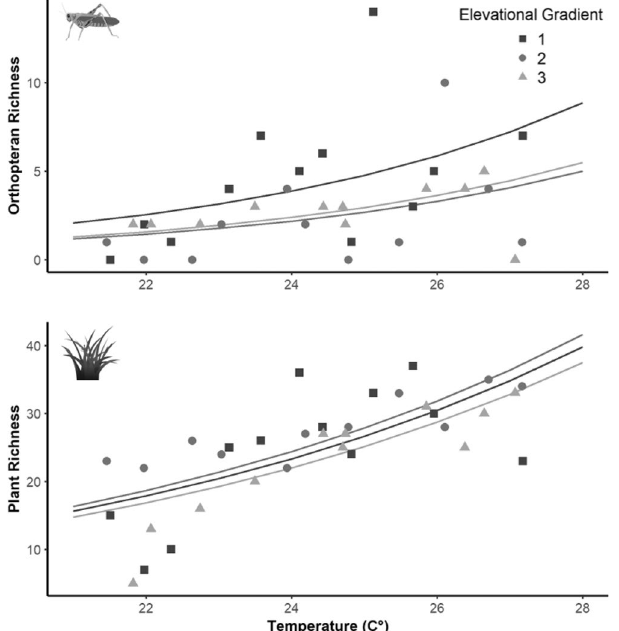
Figure 3. Conditional predictions for the best fitted models for orthoptera and plant richness. Figure generated using R software 23 .